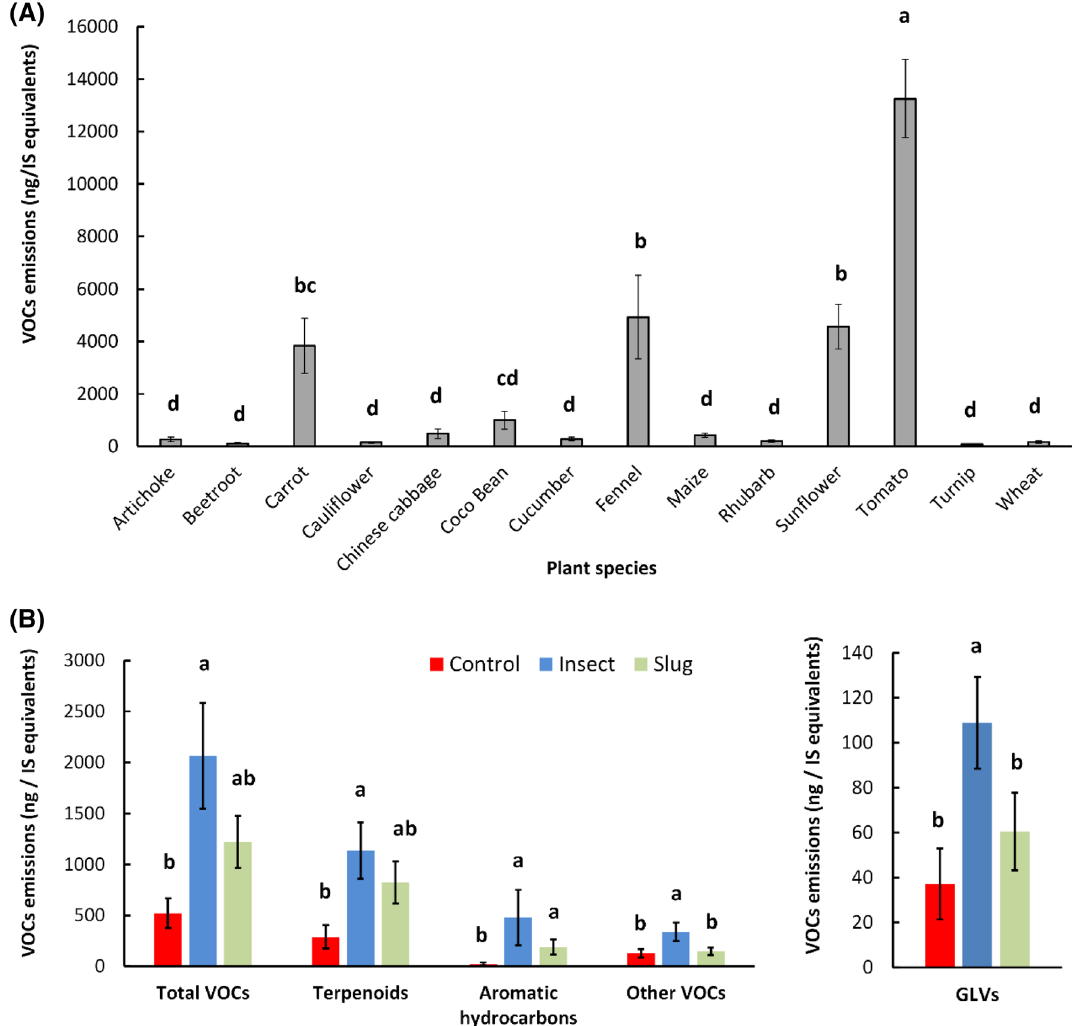
Figure 2. Variation in volatile emissions depending on plant species and herbivory treatment. ( A ) Total VOCs emissions per species, all herbivory treatments (control, caterpillar-damaged, slug-damaged) included. ( B ) VOCs emissions [Total VOCs, Terpenoids, Aromatic hydrocarbons, Green leaf volatiles (GLVs), and other VOCs] depending on herbivory treatment for all species excluding tomato. Means with a different letter are statistically different (One-way ANOVA, Tukey post-hoc test, α = 0.05, JMP®